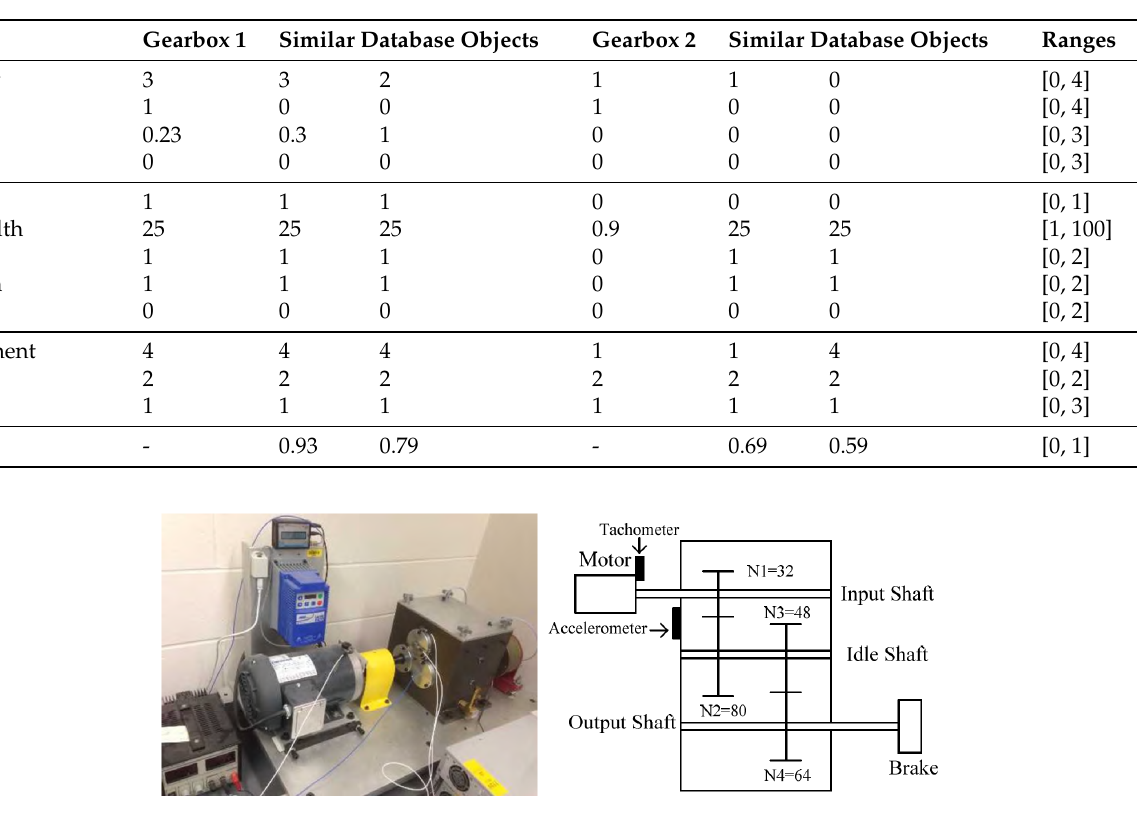
Table 4. Context information for the acquired data.